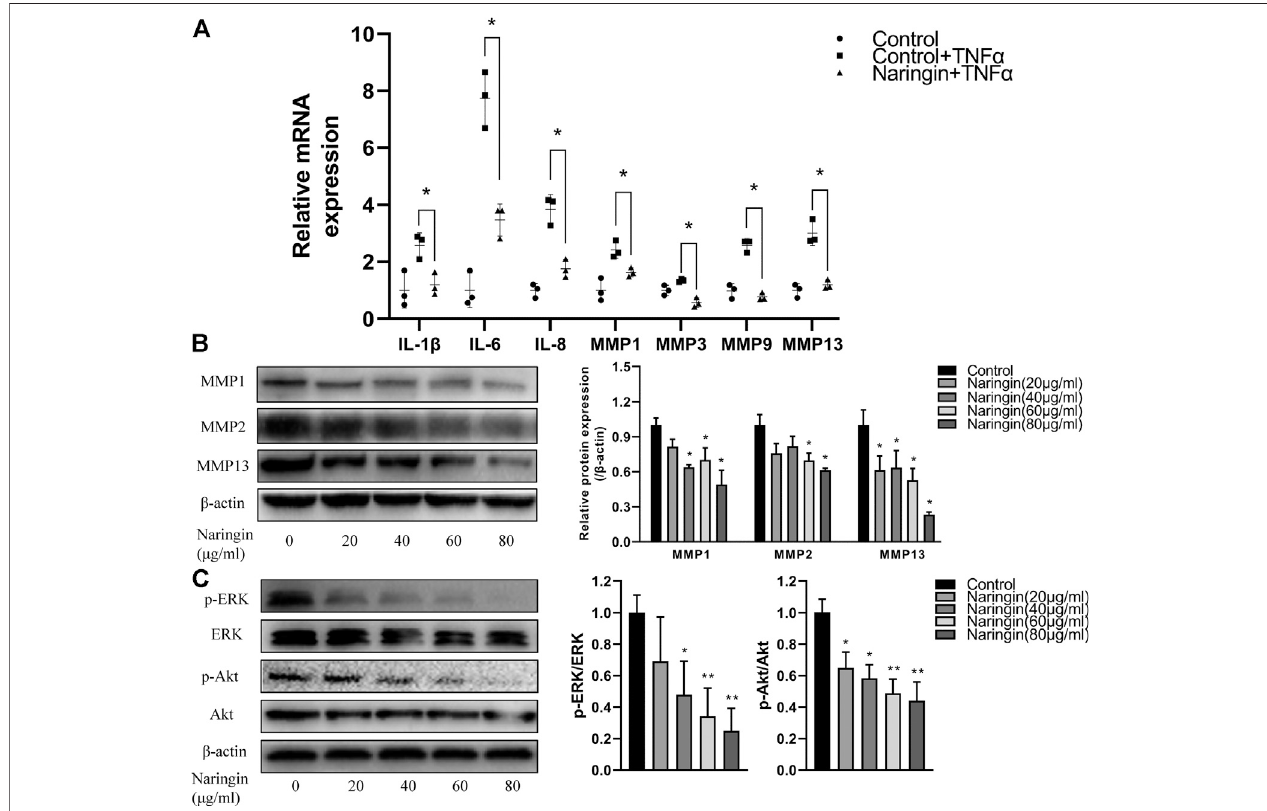
FIGURE9| Naringininhibitsin fl ammatorycytokines, MMPsand p -Aktexpression inRA-FLS. (A) Naringininhibitsin fl ammatory cytokinesandMMPsexpression in TNF- α inducedRA-FLS. (B) NaringindosedependentlyinhibitsMMPsexpressioninRA-FLS. (C) Naringininhibits p -ERKand p -AktexpressioninRA-FLS.* p < 0.05and ** p < 0.01. Each experiment was repeated for three times in different